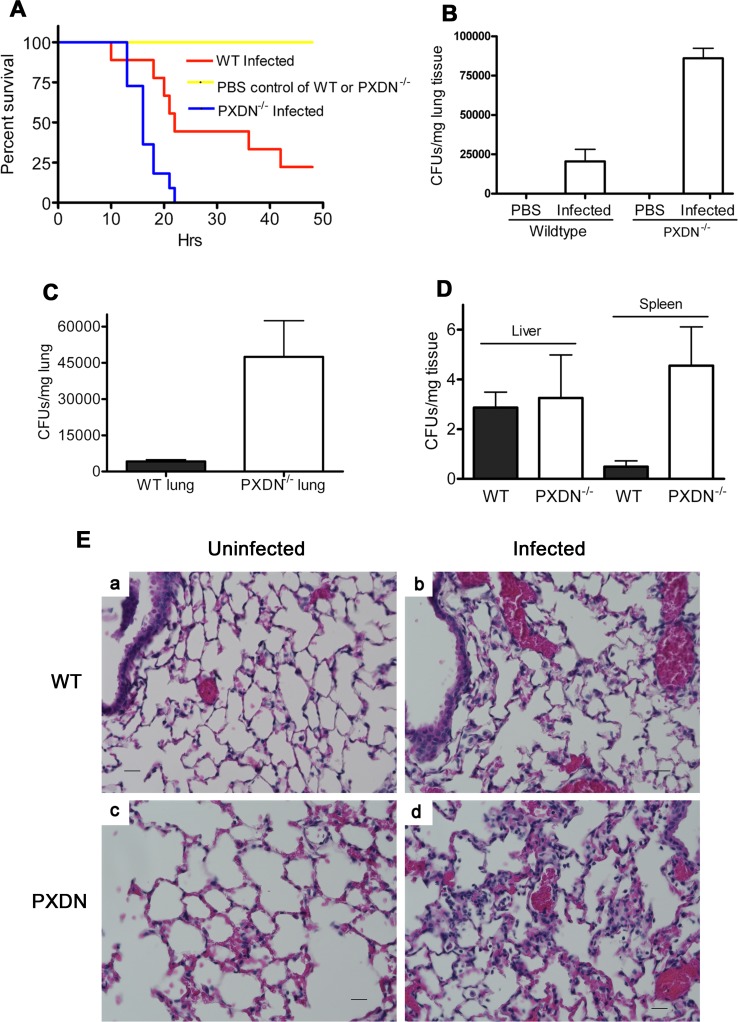
PXDN mutant mice reveal impairment in bacterial clearance during acute lung infection.(A) Decrease of relative survival rates. PXDN-deficient and C57BL/6 wild-type mice were intratracheally instilled with 7 x 106 of P. aeruginosa strain K or PBS control. Relative survival rates were determined over a period of 48 hours; n = 9–11 per group, P = 0.0068. (B) Lung Bacterial burden. Mice were sacrificed at 20 hours; lungs were aseptically removed, weighed, and homogenized in PBS. Lung tissue suspension was serially diluted and plated on LB agar plates. After incubation at 37°C for 18 h, CFUs were counted and CFUs/mg tissue were calculated; n = 12 from 4 mice per group; one-way analysis of variance, P < 0.0001 for all comparisons. (C and D) Tissue burden on bacterial infection with sublethal dose was carried out by intratracheally infecting the mice with 3 x 106 of P. aeruginosa strain K. After 20 h, lung, liver and spleen were taken as in (B) for detection of bacteria. n = 15–21 from 5–7 mice per group; P (lung) = 0.016; P (liver) = 0.843; P (spleen) = 0.014. (E) H&E staining of the lungs from uninfected and infected mice. Mice were infected as in (C) and the lungs were harvested at 20 h for preparation of staining. a. WT mouse, uninfected; b, WT mouse, infected; c. PXDN-deficient mouse, uninfected; d, PXDN-deficient mouse, infected. Magnification: 400x. Scale: 5μm.